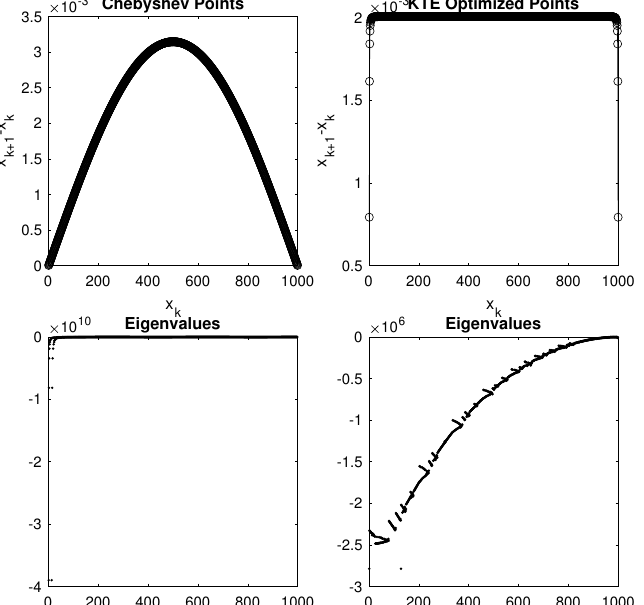
Figure 5. Chebyshev points, KTE optimized points, and their eigenvalues for a 37 point stencil with polynomials up to degree p = 15. In this case, both point sets produce purely real